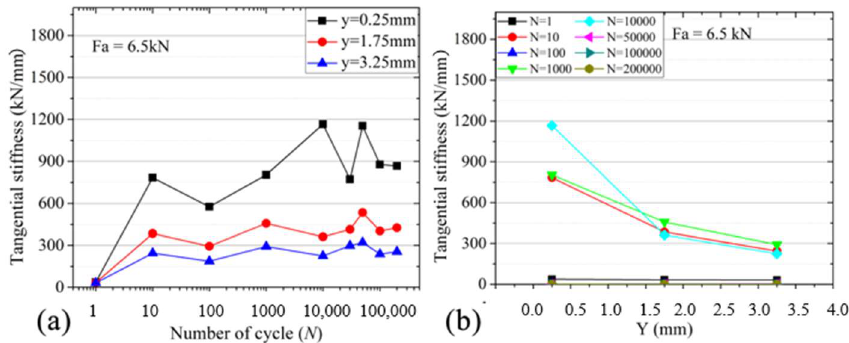
Figure 13. ( a ) Evolution of tangential stiffness with the number of cycles and ( b ) distribution of tangential stiffness along the contact surface for the 6.5 kN case.